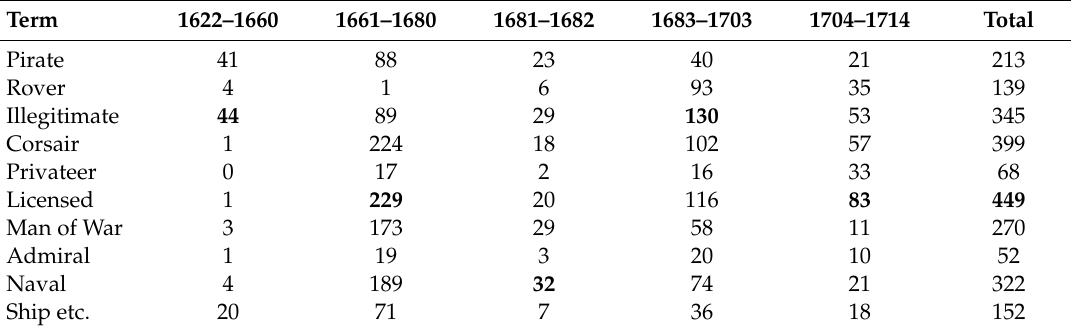
Table 4. Classifications for Maghrebi ships at sea (% of articles employing term within entire corpus, highlighting most common category in each period).